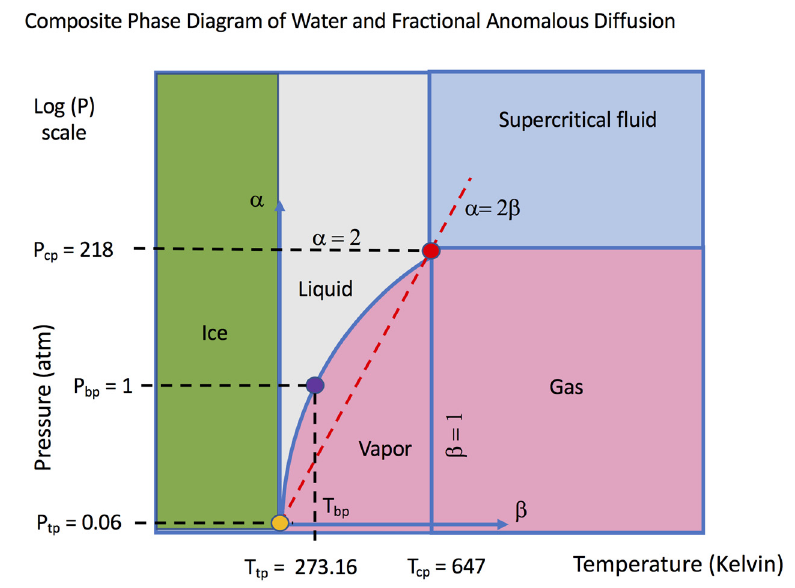
Figure 5. Composite pressure-temperature { P , T } phase diagram of water with the fractional anomalous diffusion { 𝛽 , 𝛼 } phase diagram. The critical point of water is taken to be equivalent with the Gaussian case of normal diffusion. In this example, the triple point of water appears near the origin of the anomalous diffusion diagram, while the boiling point is at the location, { 𝛽 = 0.27, 𝛼 = 0.97} .